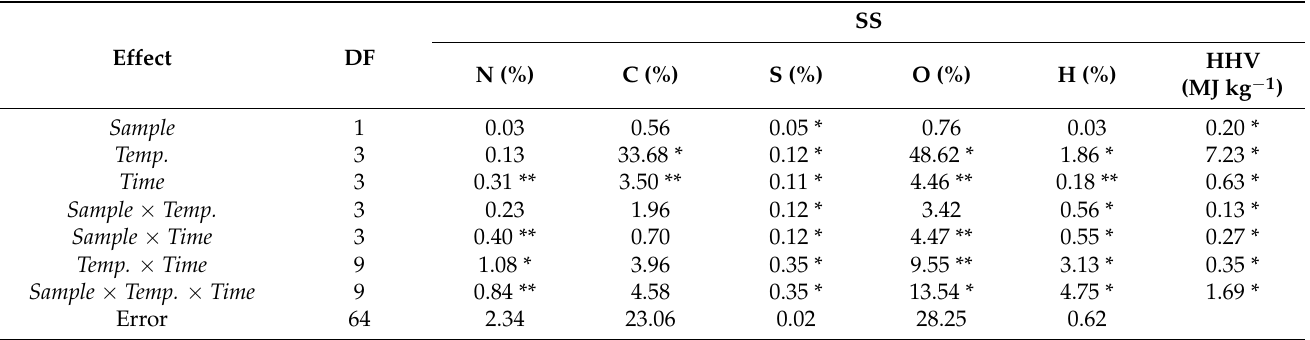
Table 8. Univariate analysis of the change in ultimate and calorimetric analysis of hazelnuts in relation to sample parameters, duration, and drying